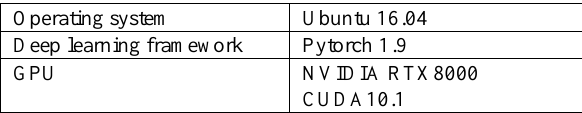
Table 2. Experimental setup used in the study